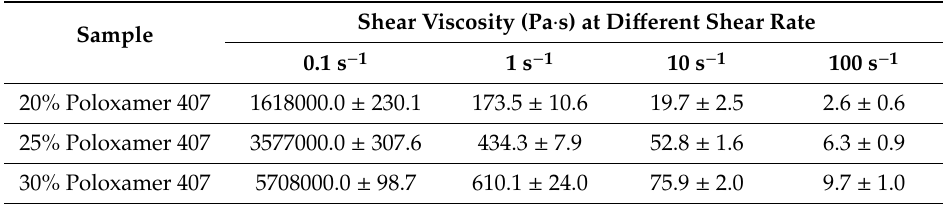
Table 3. Shear rate-dependent viscosity (Pa · s) for Poloxamer 407 gels at 25 ◦ C and at di ff erent shear rates. Values are reported as the average of three independent experiments ± standard